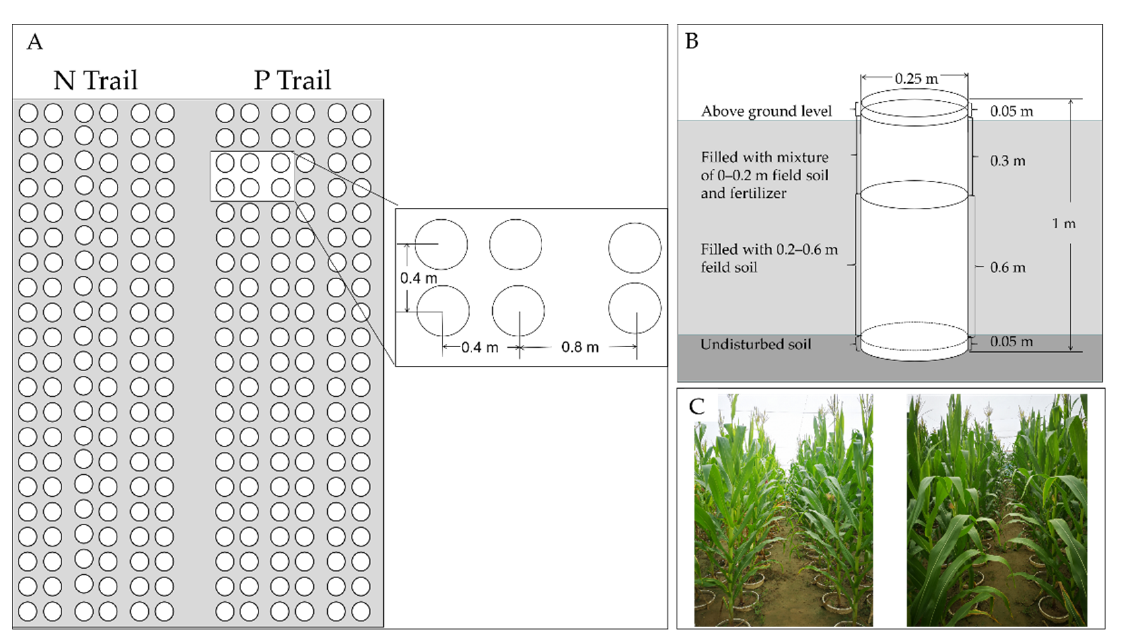
Figure 1. Schematic diagrams of the soil columns used for maize cultivation. ( A ) an aerial schematic diagram of the soil column arrangement. The small circles indicate the positions of the soil columns. ( B ) a diagram showing how columns were filled with soil. ( C ) image showing maize cultivation in the field.